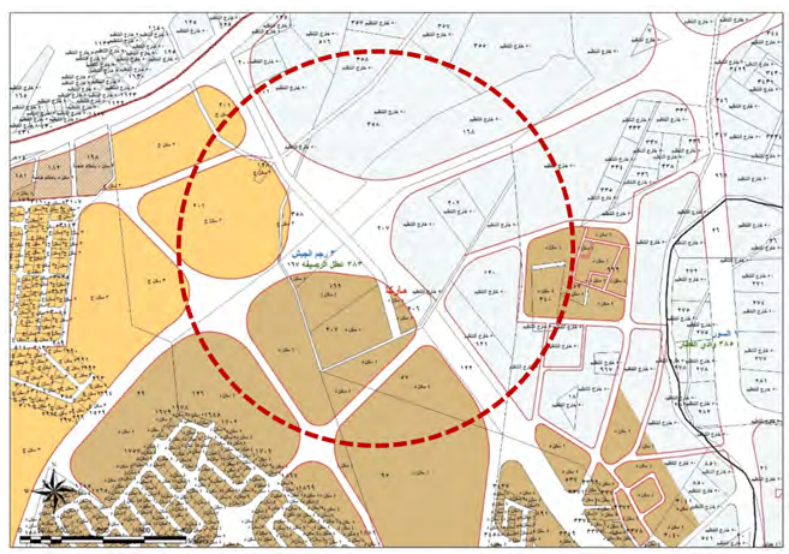
Figure 25. Scrap yard site land use map. Source: GAM- GIS for the author (2016).